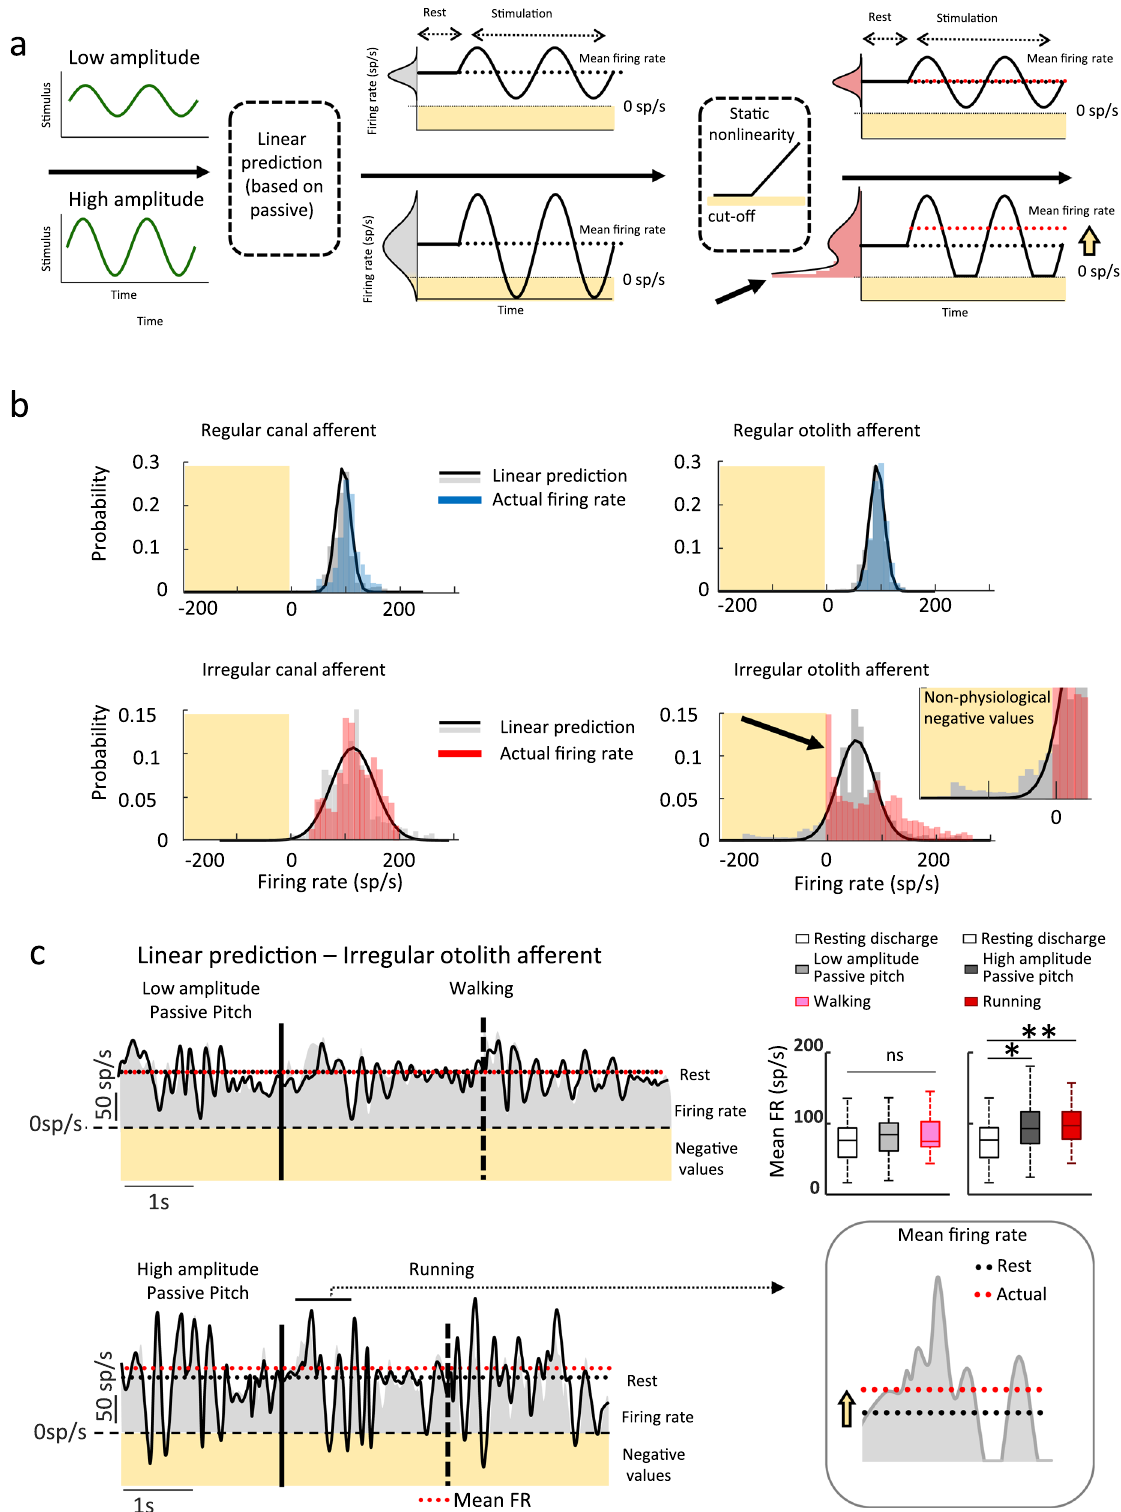
afferents speci fi cally show a spike in the probability of fi ring at zero sp/s during running. Thus, highly sensitive irregular otolith afferents are indeed characterized by a strong nonlinearity (inhibitory cutoff) that is primarily elicited by the more vigorous stimulation experienced during